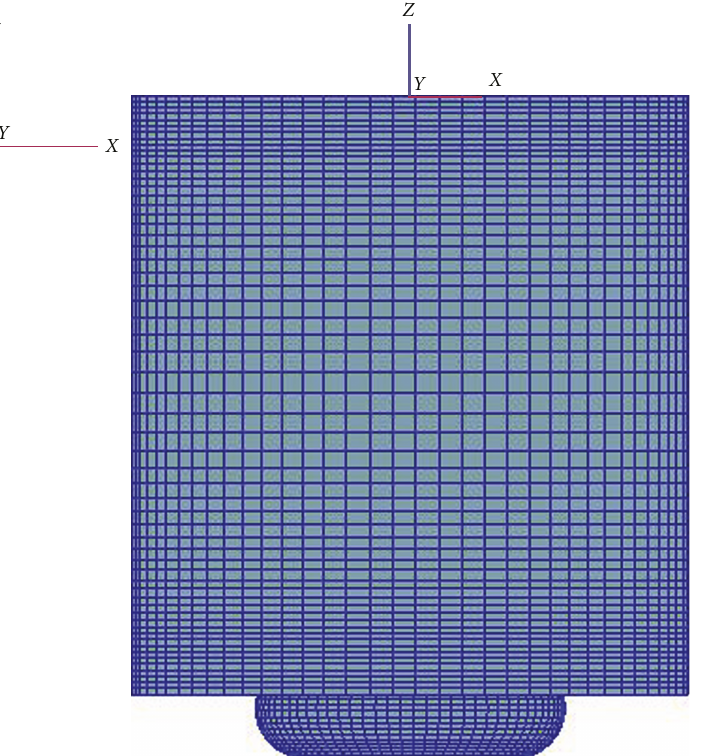
Figure 2: The meshes of the combustion chamber under 850 °